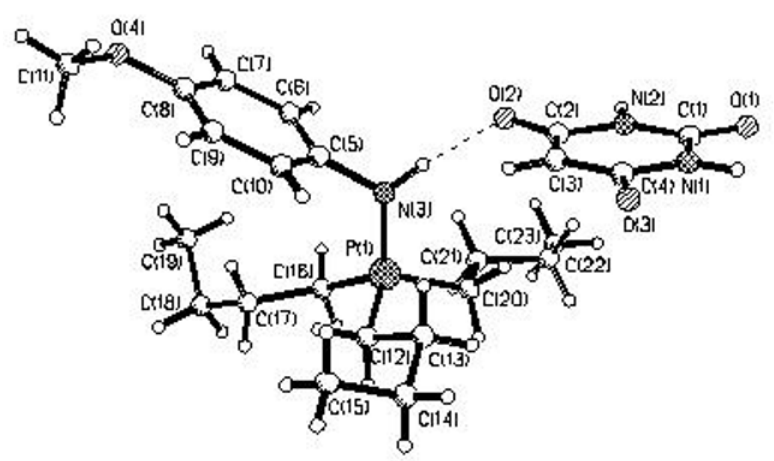
Figure 2. Molecular structure of 6f according to an X-ray diffraction